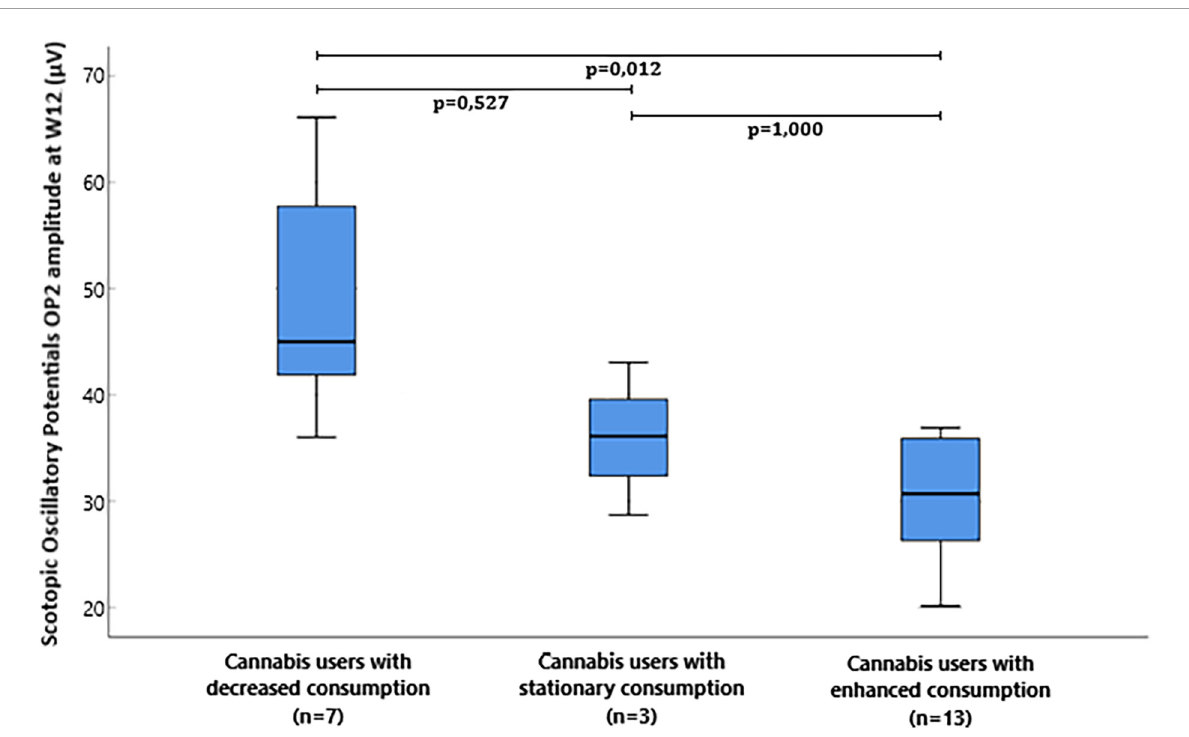
FIGURE3 Box plot of flash electroretinogram (ERG) scotopic oscillatory potentials OP2 amplitude microvolts ( µ V) at W12 in cannabis users divided in groups depending on the evolution of consumption between W8 and